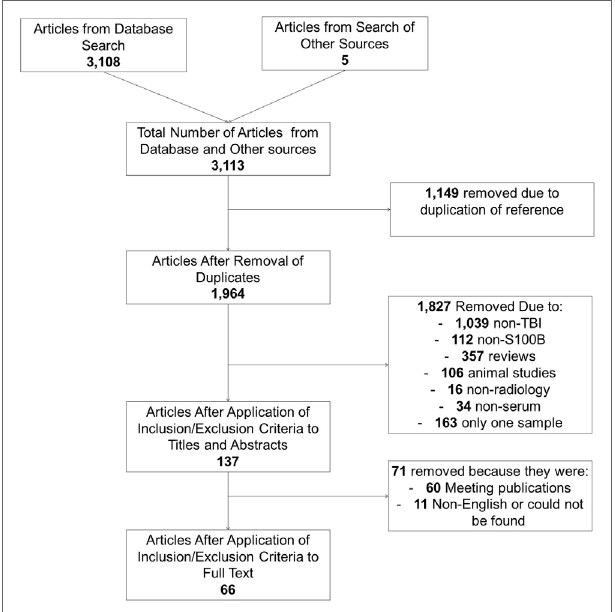
FigURe 1 | Illustrating the selection of articles with serial sampling of